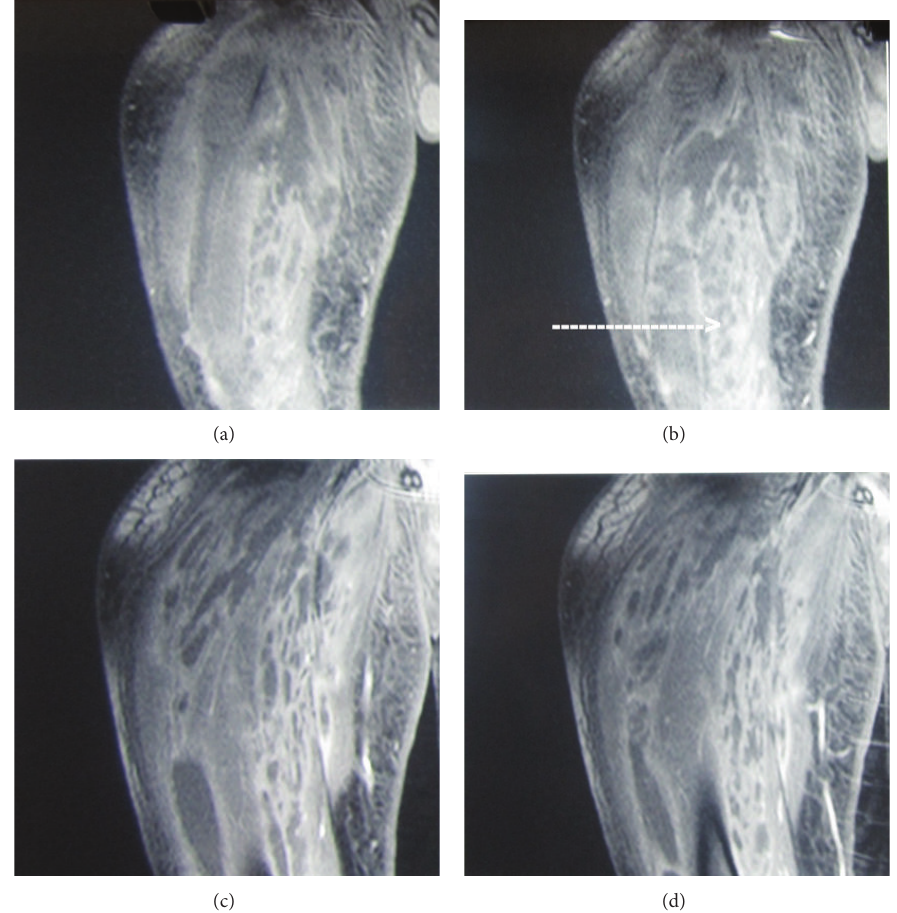
Figure 3: MRI right thigh—MRI coronal T1W—showing a diffuse septated intramuscular collection suggestive of pyomyositis of quadriceps femoris.